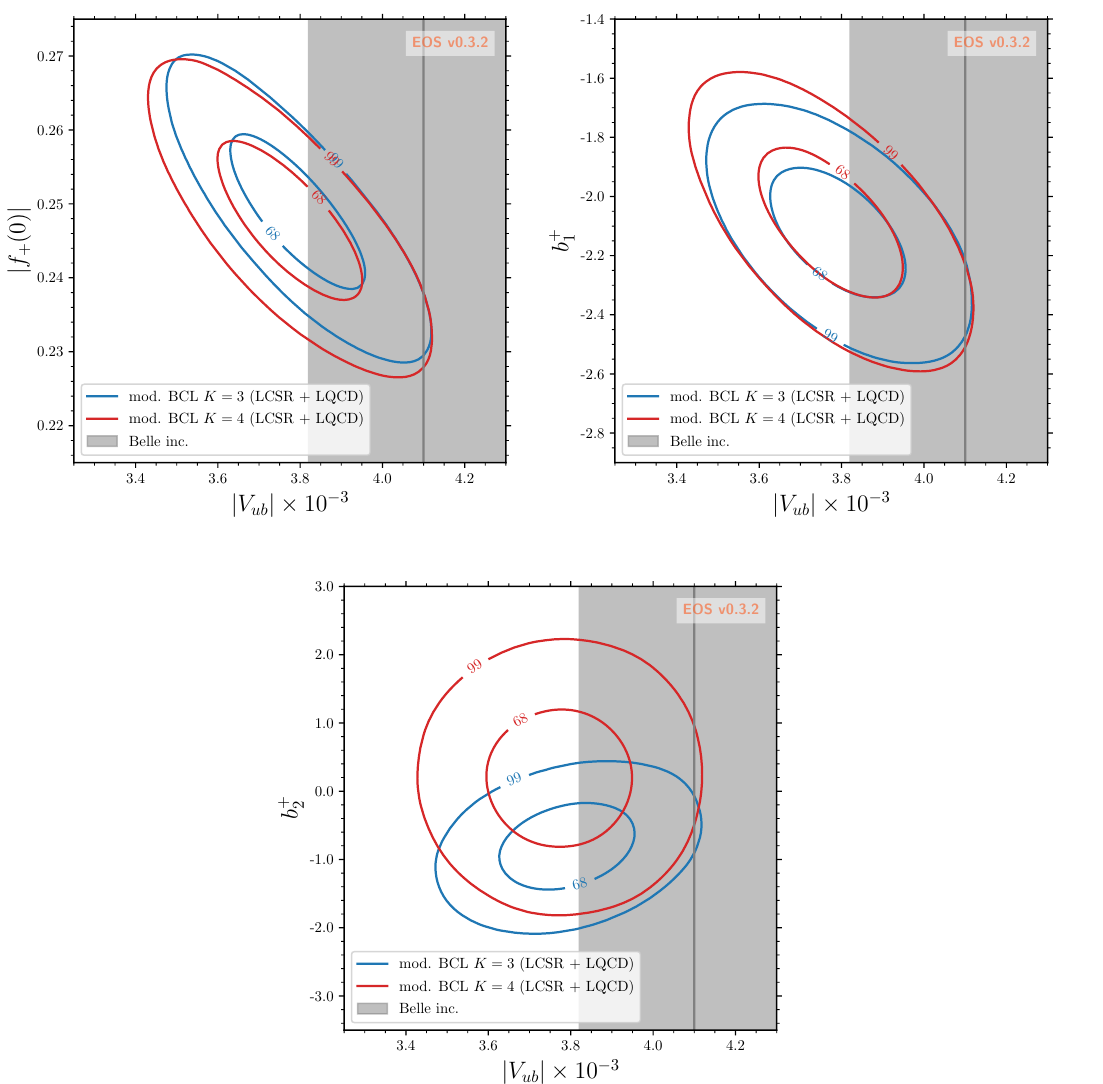
Figure 9 . Contours of the two-dimensional marginalised posterior distributions of the K = 3 and K = 4 fits to both theory inputs and experimental data at 68% and 99% probability. For a description of the fits, see section 5. The most recent Belle result [10] for the inclusive | V ub | determination is shown as a gray line (central value) and band